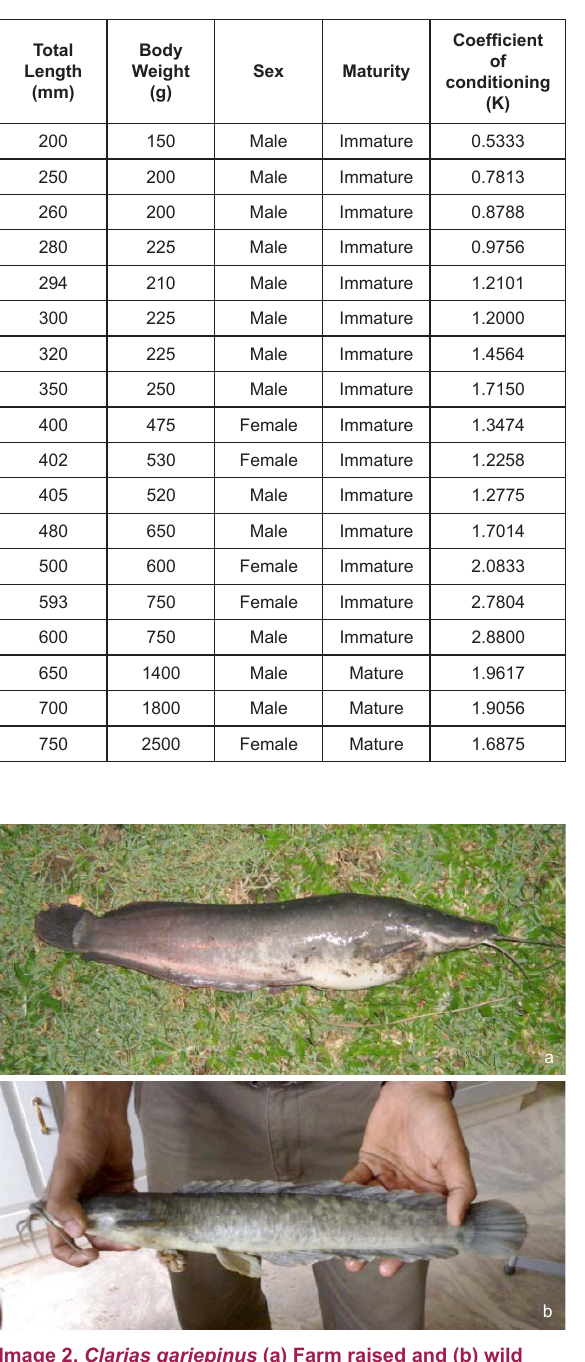
Table 1. Biological data of C. gariepinus individuals caught from Lake